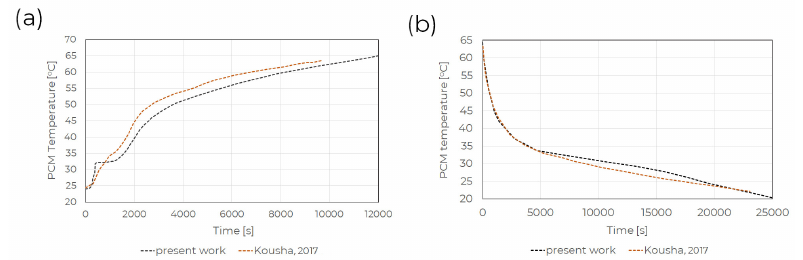
Figure 5. Numerical methodology validation of the shell-and-tube system [80] ( a ) comparison of the average PCM temperature during melting, ( b ) comparison of the average PCM temperature during